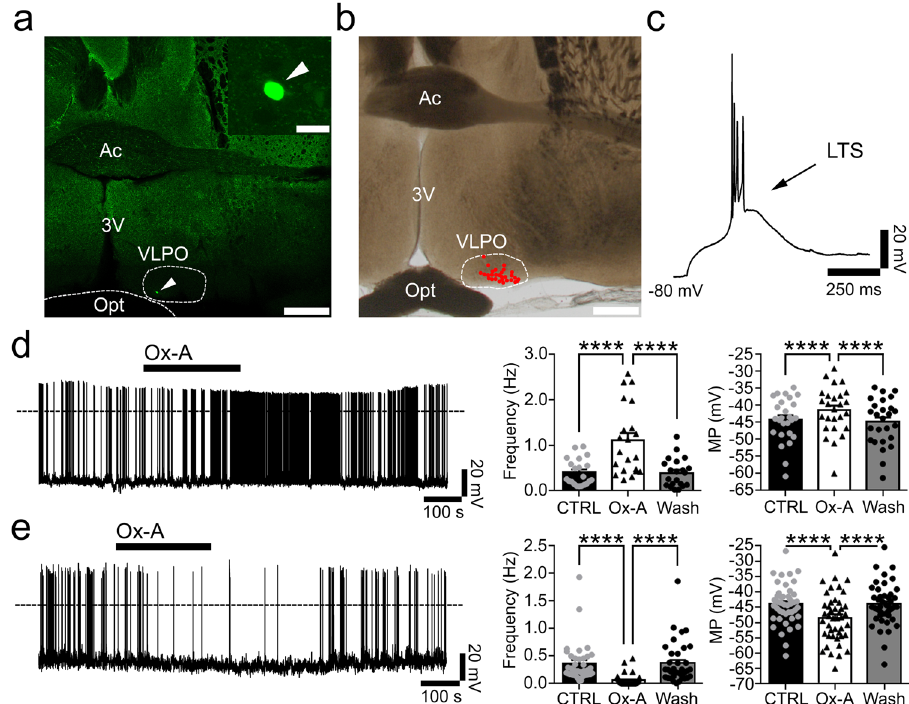
Fig. 2 Dual response of orexin in VLPO. a Whole-cell recordings of VLPO neurons and post-hoc labeling of a biocytin- fi lled neuron (scale bars: 500 and 20 µ m). b Map of the recorded neurons in VLPO ( n = 29; scale bar: 500 µ m). c Most of VLPO neurons exhibit LTS (80 out of 116). d Ox-A (0.3-1 µ M) excites 35% of the VLPO neurons: it increases action potential fi ring frequency ( n = 21; one-way ANOVA, F (2, 60) = 30.49; p < 0.0001; CTRL vs Ox-A and Ox-A vs. Wash, adj-p < 0.0001) and depolarizes the membrane potential ( n = 26; one-way ANOVA, F (2, 75) = 49.89; p < 0.0001; CTRL vs Ox-A and Ox-A vs Wash, adj-p < 0.0001). e Ox-A inhibits 60% of the VLPO neurons: it reduces action potential fi ring frequency ( n = 37; one-way ANOVA , F (2, 108) = 28.56; p < 0.0001; CTRL vs Ox-A and Ox-A vs Wash, adj-p < 0.0001) and hyperpolarizes membrane potential ( n = 44; one-way ANOVA, F (2, 129) = 63.18; p < 0.0001; CTRL vs Ox-A and Ox-A vs Wash, adj-p < 0.0001). **** p < 0.0001, Bonferroni ’ s post-hoc test. Ac, anterior commissure; 3V, 3 rd ventricle; Opt, optical chiasm. Panel d and e : data are represented as means± SEM, n refers to the number of recorded neurons and Source Data are provided as a Source Data fi